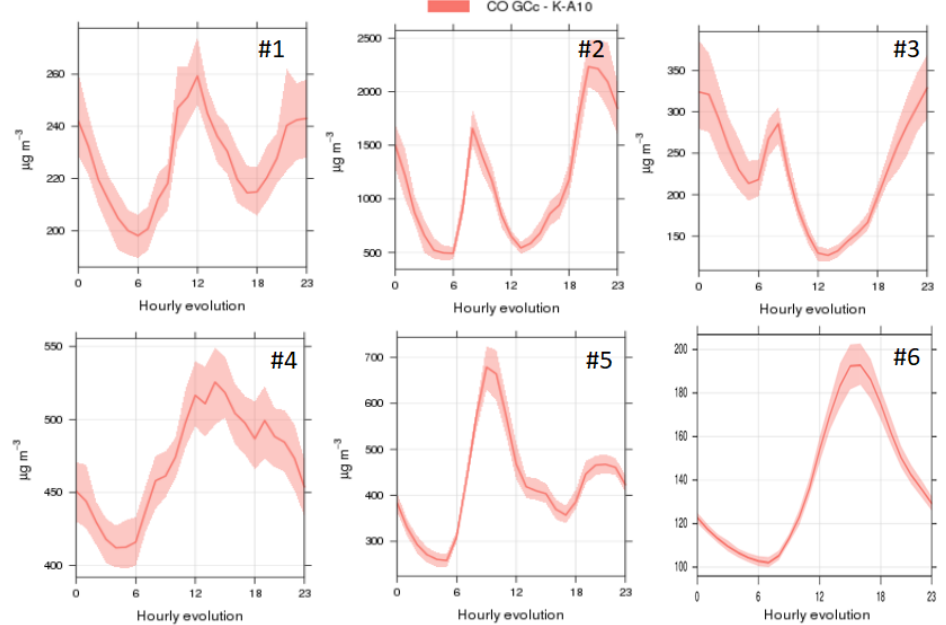
Figure 2. Mean daily evolution of CO for the months July–September 2019, for the 6 stadia in major cities in: #1: Europe, #2: Africa, #3: Oceania; #4: Asia; #5: America; #6: Africa (data from October–